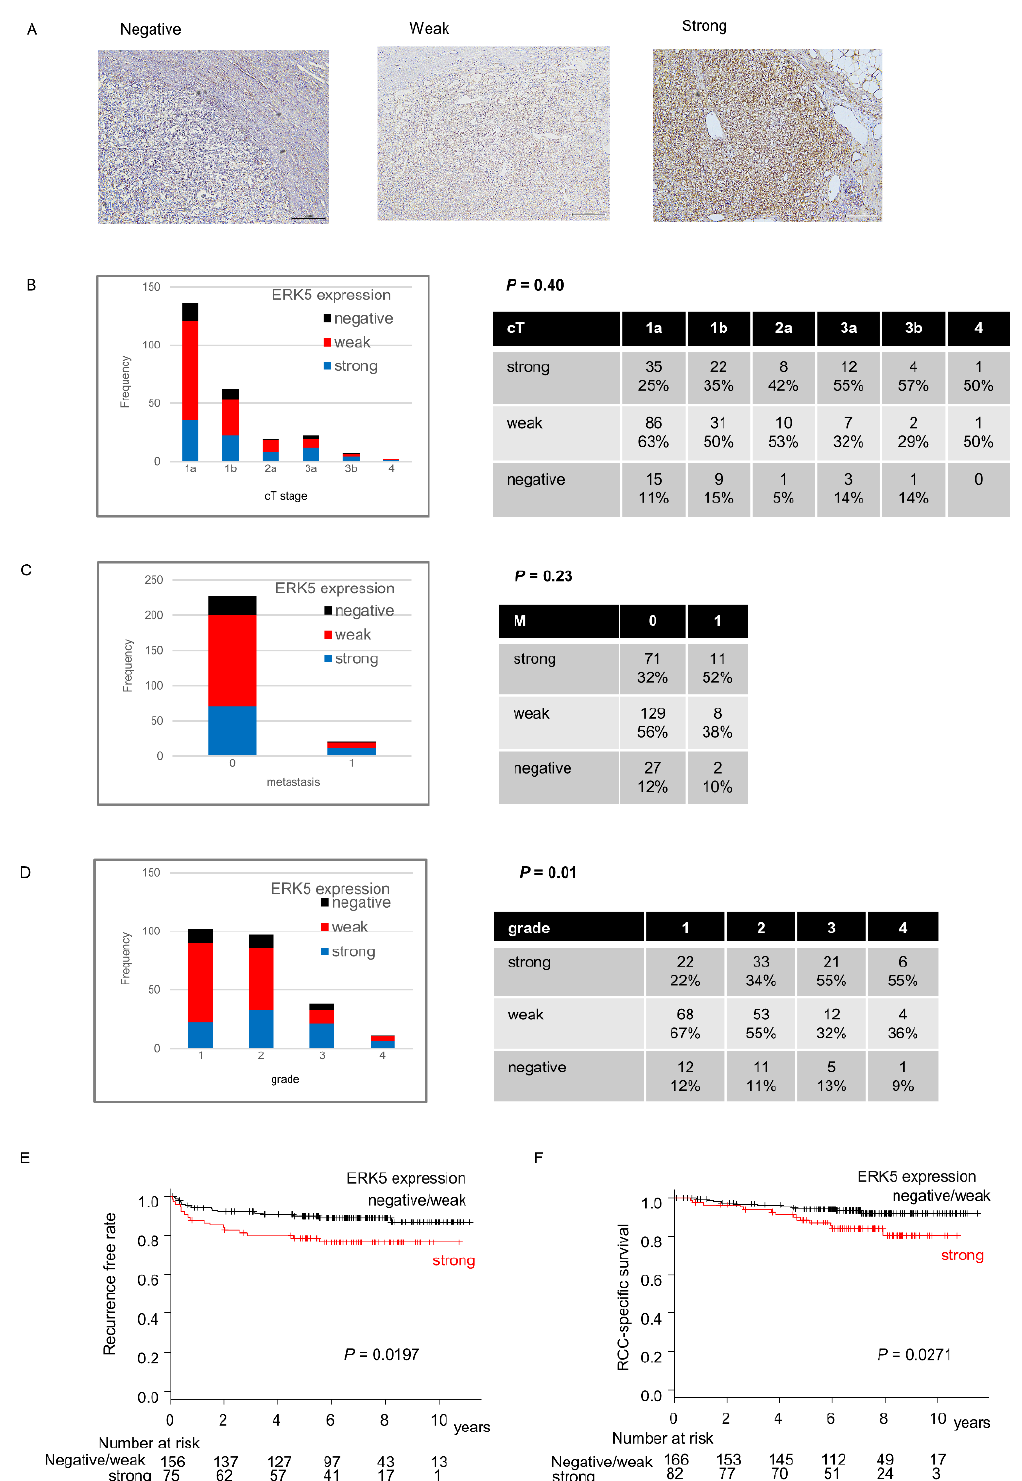
Figure 1. ERK5 expression in ccRCC specimens. ( A ) Representatives of negative, weak, and strong expression of ERK5 in immunohistochemistry specimens. ( B ) ERK5 expression level by each cT stage. ( C ) ERK5 expression level by each M stage. ( D ) ERK5 expression level by each grade. ( E ) Recurrence-free survival divided by ERK5 expression. ( F ) Cancer-specific survival divided by ERK5 expression. Abbreviations; ERK5, extracellular signal-regulated protein kinase 5; ccRCC, clear cell renal cell